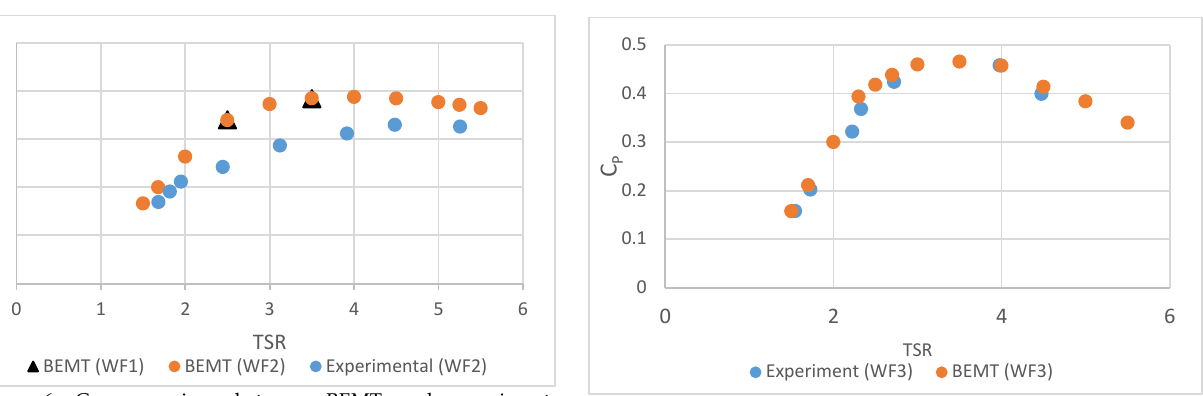
Figure 8. C P comparison between BEMT and experiments undertaken at Insean for the 1.0 m/s case when the turbine operated under wave-current interactions with a wave height of approximately 0.4m and an apparent wave period of 1.5s